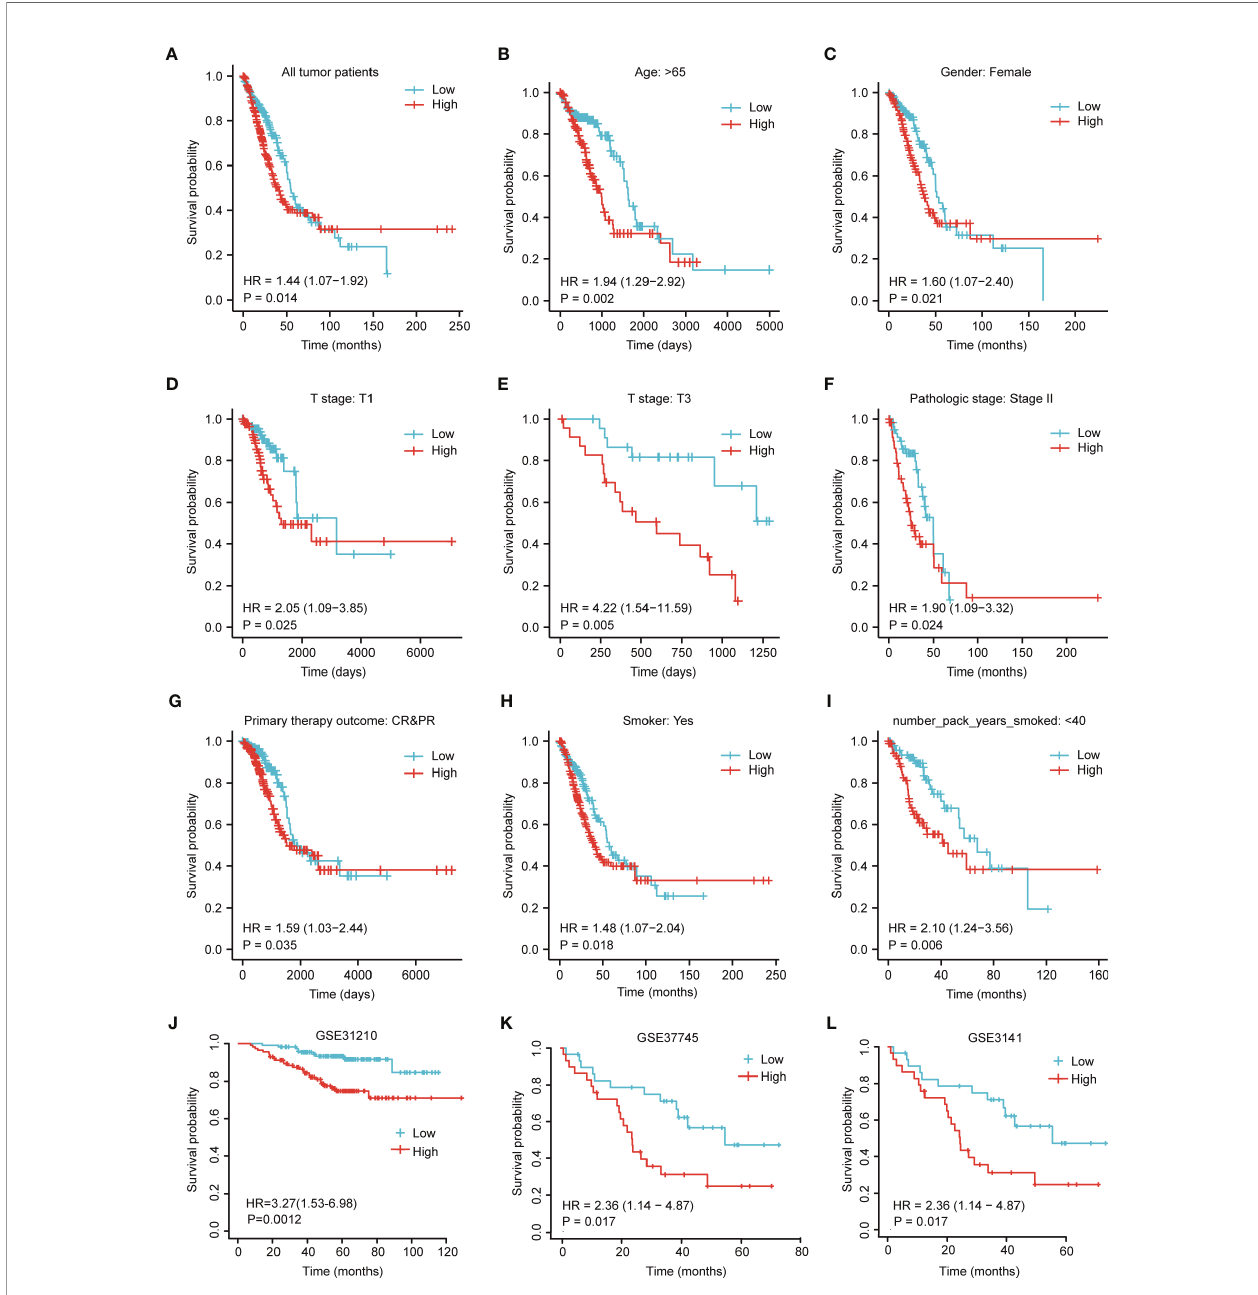
FIGURE 5 | Kaplan – Meier survival curve analysis of the prognostic signi fi cance of a high and a low expression of glucose-6-phosphate isomerase (GPI) in lung adenocarcinoma (LUAD) using The Cancer Genome Atlas (TCGA) and Gene Expression Omnibus (GEO) databases. (A) Kaplan – Meier estimates of the overall survival probability of TCGA patients in all LUAD patients. (B – L) Subgroup analysis for age greater than 65 years (B) , female patients (C) , T1 (D) , T3 (E) , pathological staging stage II (F) , complete/partial response (CR/PR) (G) , smokers (H) , and smokers over 40 years old (I) and tumor patients in the GEO datasets: GSE31210 (J) , GSE37745 (K) , and GSE3141 (L)